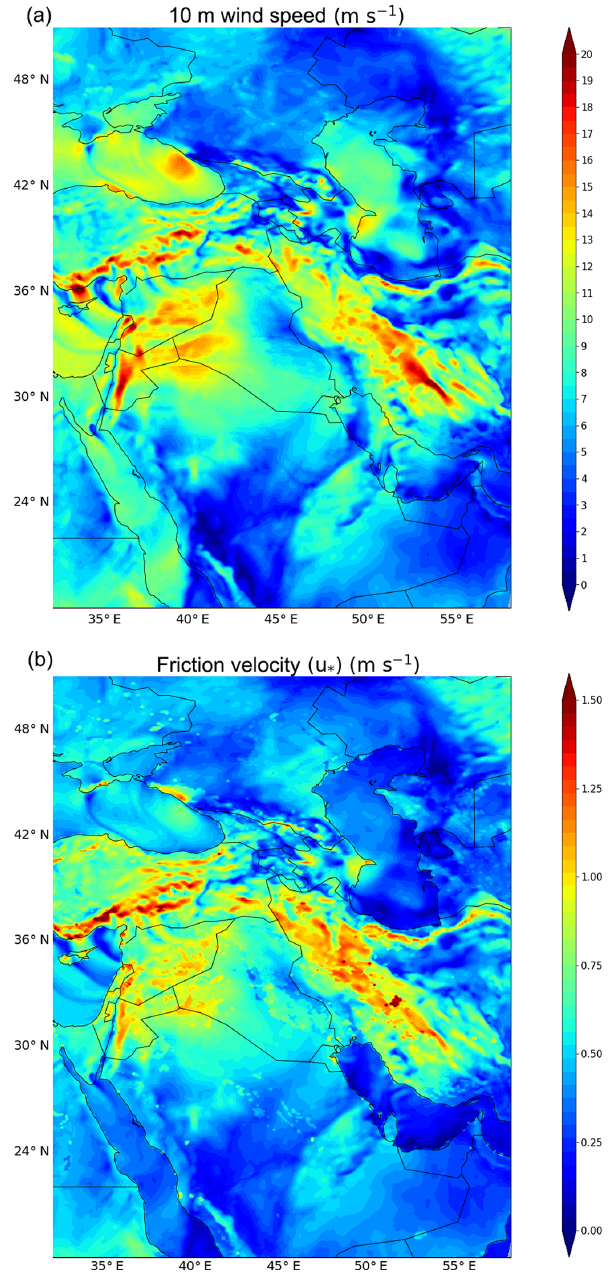
Figure 10. Simulated wind speed (a) and friction velocity (b) at 11:00UTC on 25 January